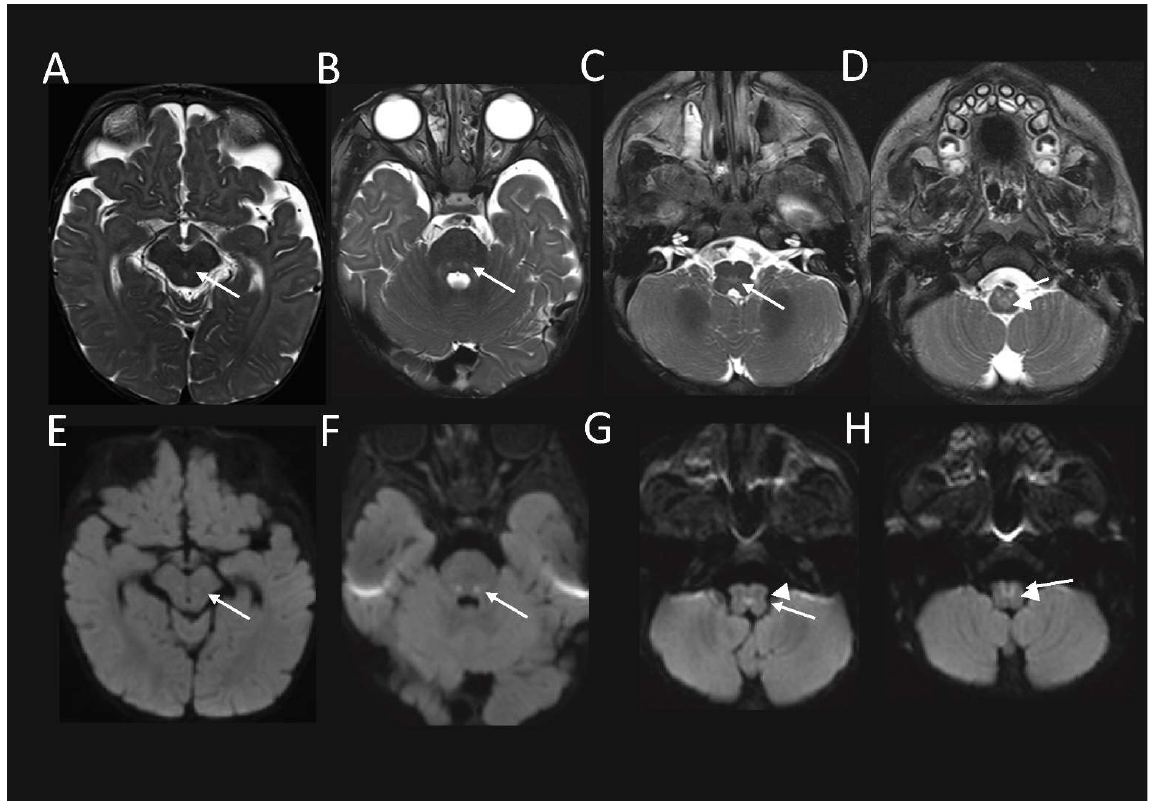
Figure 2. Brain MRI from the patient with compound heterozygous PYROXD2 variants at 6 months . The axial T2-weighted sequence shows the interval development of abnormally high signal in the ( A ) red nuclei at the midbrain level; ( B ) central tegmental tracts and medial lemnisci (ML) (arrow), at the level of mid pons; ( C ) central dorsal medulla, involving the middle longitudinal fasciculi (MLF), and the tectospinal tracts (arrow), at the open medullary level; and ( D ) sensory decussation of ML (arrowhead), and MLF (arrow) at the upper part of closed medulla, with corresponding restricted diffusion ( E – H ) on diffusion-weighted imaging.